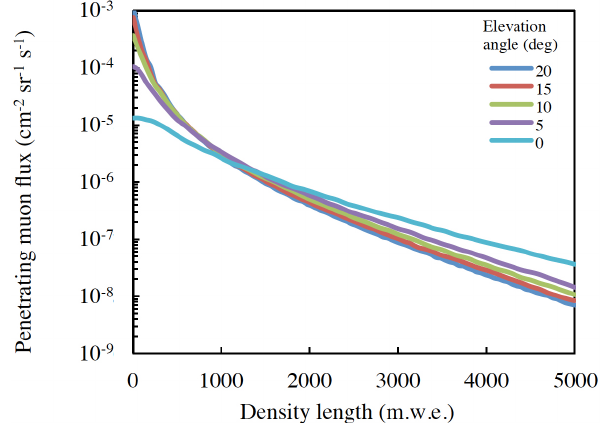
Figure 2. Elevation angle dependence on muon flux after passing through a given rock thickness. The rock thickness is given in units of meter water equivalent (m.w.e.).